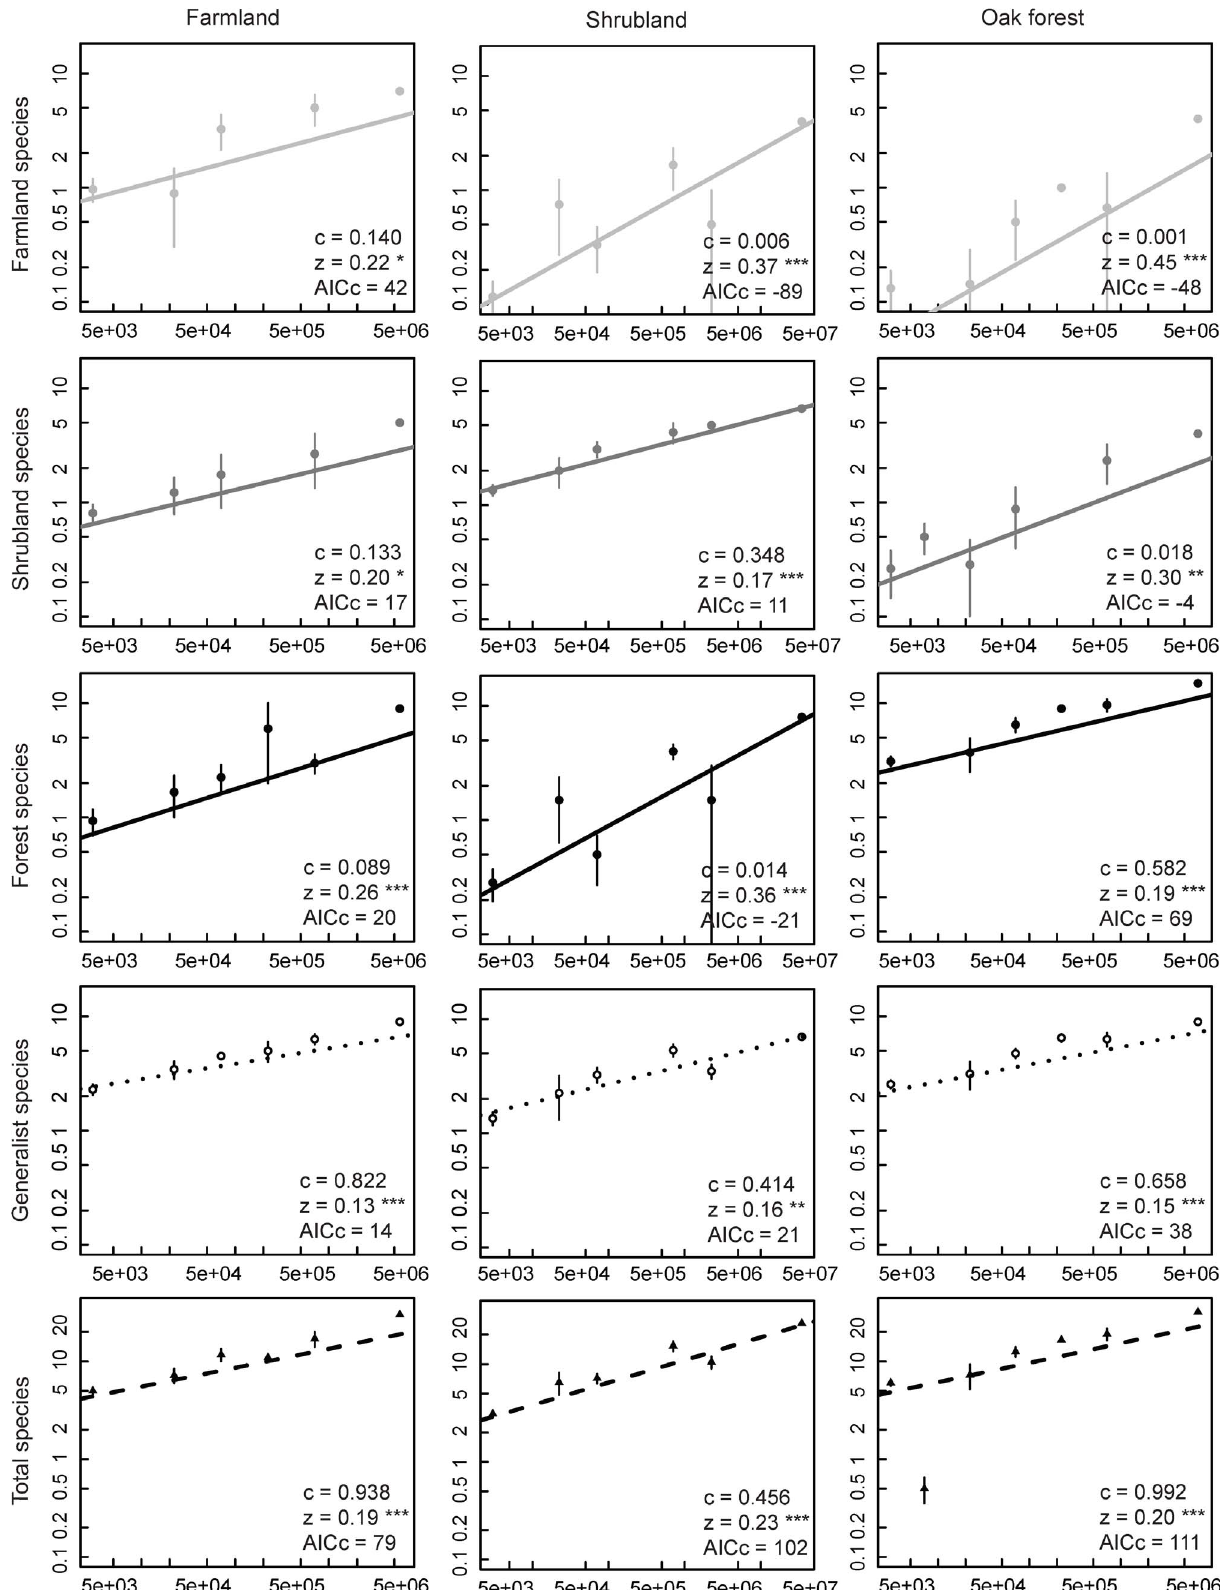
Figure 4. Plots of classic-SAR of each species group and total species in the three land-uses. Species-area relationships are represented in the Log-Log space for each species group (farmland, shrubland, forest and generalist species) and total species in each land-use (farmland, shrubland